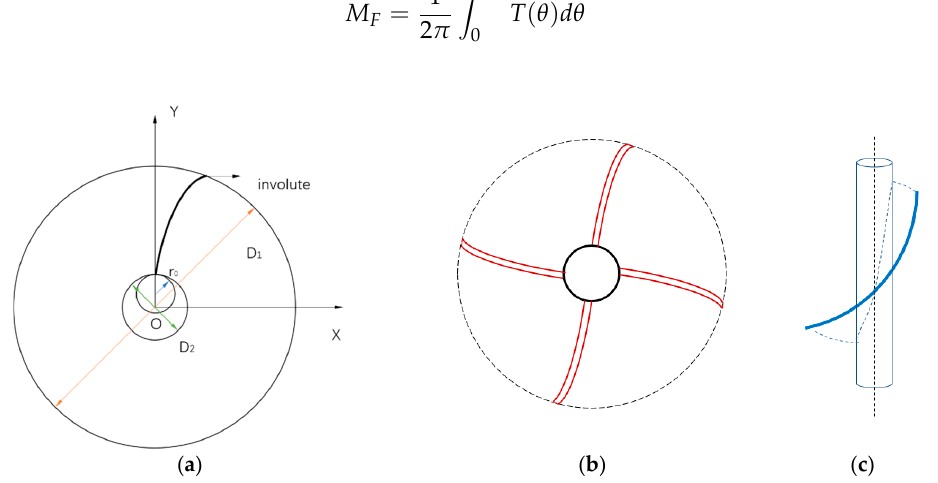
Figure 3. Blade design schematics for ( a ) Involute blade size determination; ( b ) Blade axial top view schematic; and ( c ) Radial blade schematic.